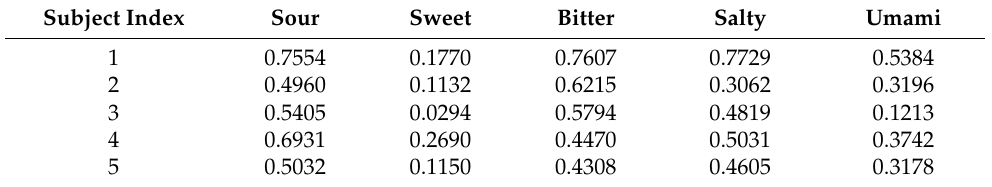
Table 8. Regression results for all